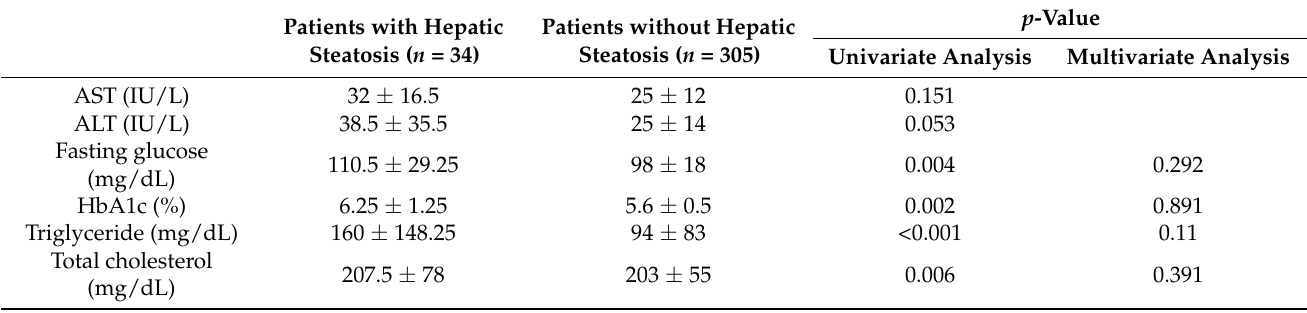
Table 3. Comparison of clinical parameters between the two groups determined by the hepatic steatosis criterion (c; CT L-S < −